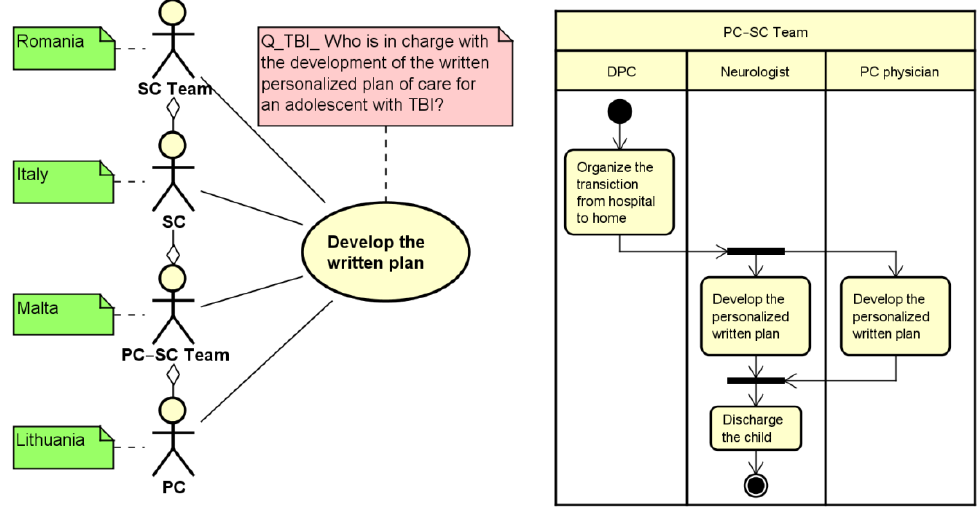
Figure 1. An example of customization of use case (left side) and activity (right side) diagrams, for Developing a Personalized Care Plan. PC = Primary care professionals; SC = Secondary care; DPC = Discharge Planning Coordinator.